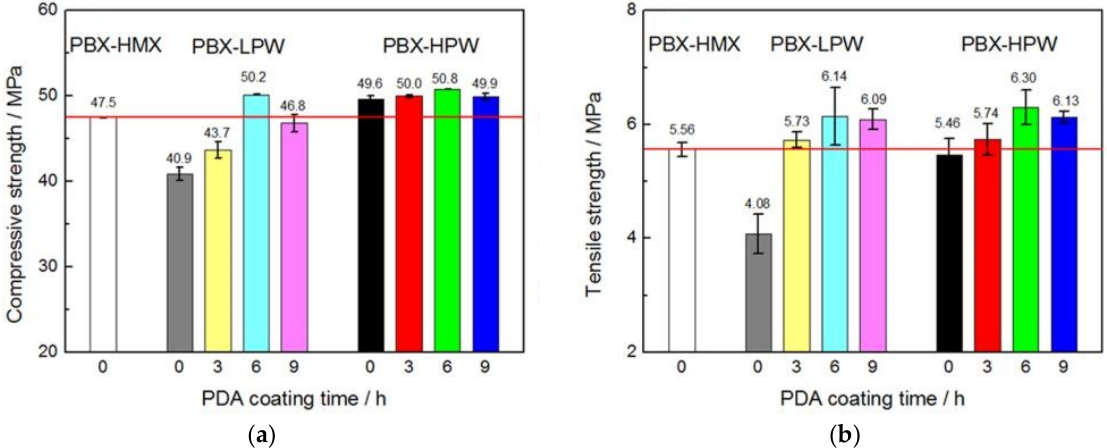
Figure 7. Compressive- ( a ) and tensile strength ( b ) of HMX, HMX@wax and HMX@wax@PDA-based energetic composites. Reproduced with permission from [66], copyright 2020, American Chemical Society.